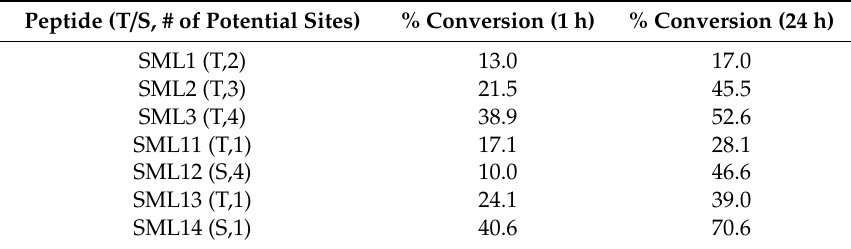
Table 2. BclA3 peptide glycosylation conversion rates of reactions with MalE-SgtA and UDP-GlcNAc. The % conversion rates correspond to the integration of all the product peaks identified by CE analysis. #: number of potential sites.